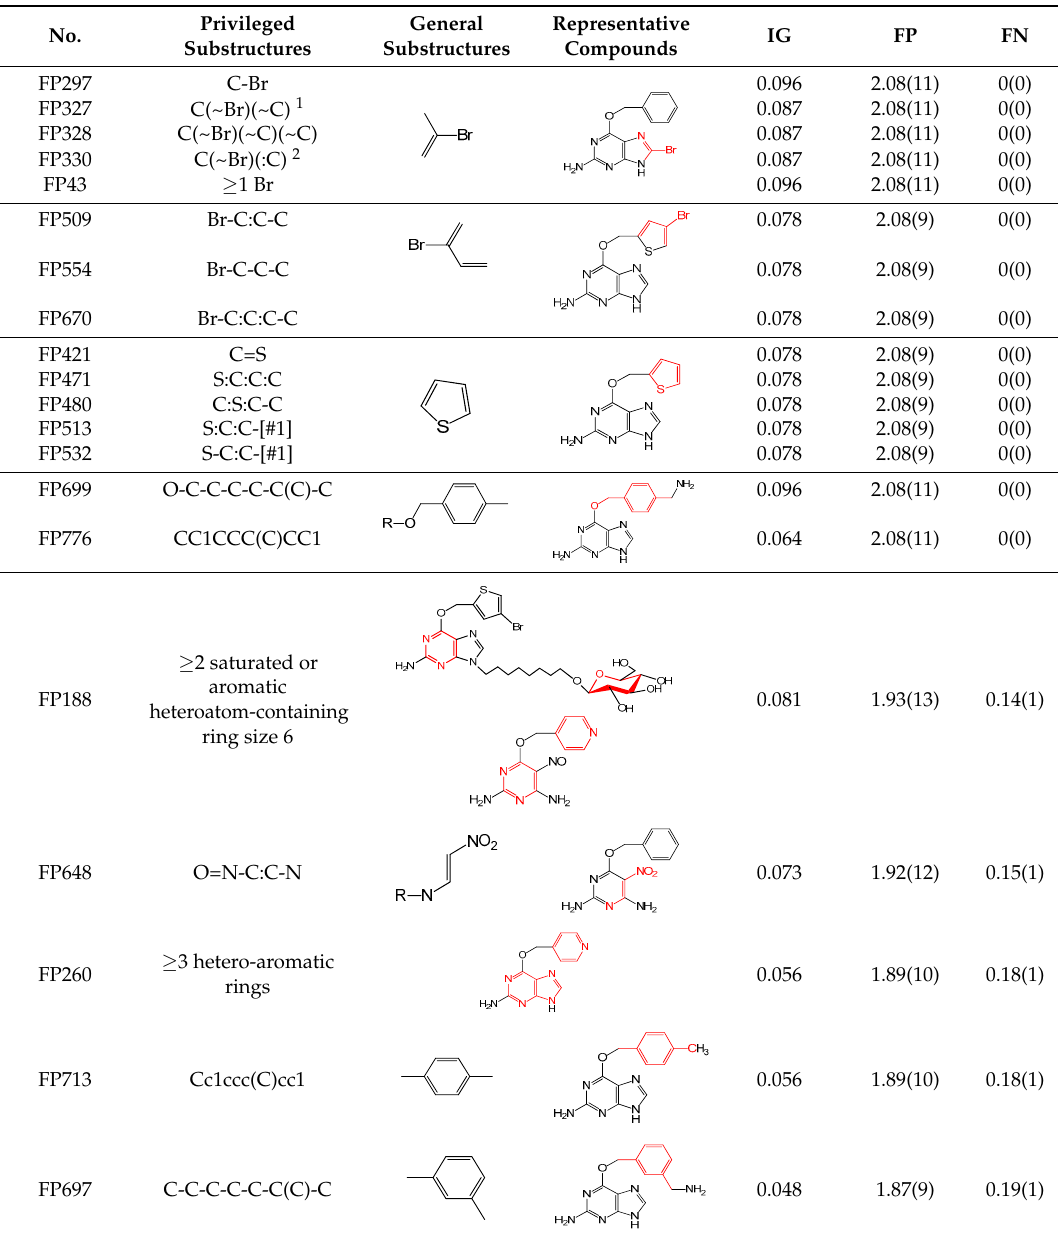
Table 3. Representative privileged substructures obtained from PubChem fingerprint responsible for O 6 -methylguanine-DNA methyltransferase (MGMT) inhibition in base analogs. No.